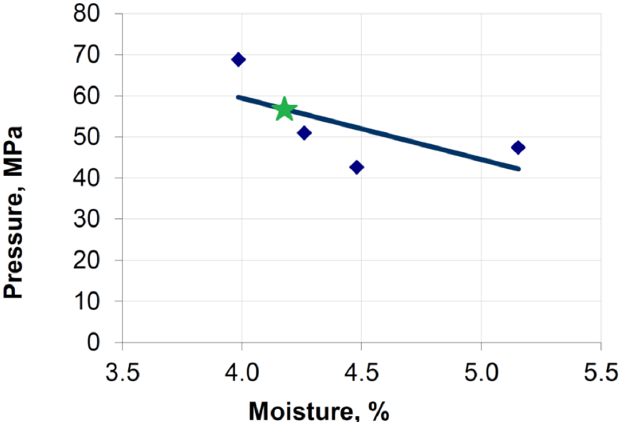
Figure 13. Influence of moisture content of raw materials on the specific pressure exerted on the bottom of the forming element when briquetting a mixture based on copper ore concentrate in a roller press [55]: the green star is for moisture 4.2%. roller press [55]: the green star is for moisture